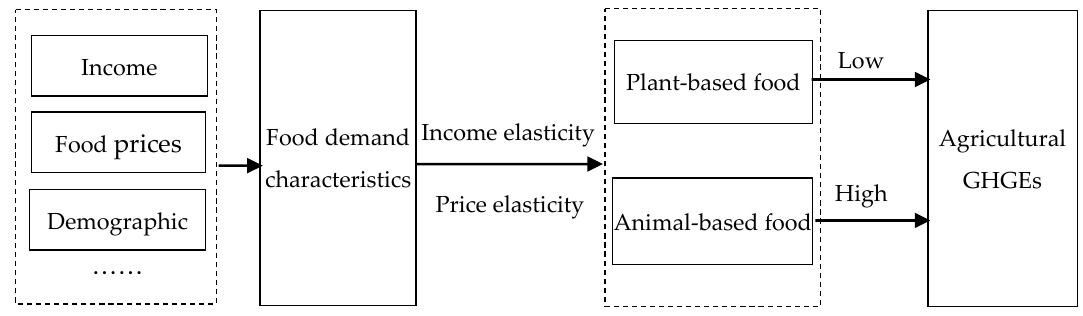
Figure 1. Conceptual framework of changing food demands and related GHGEs.